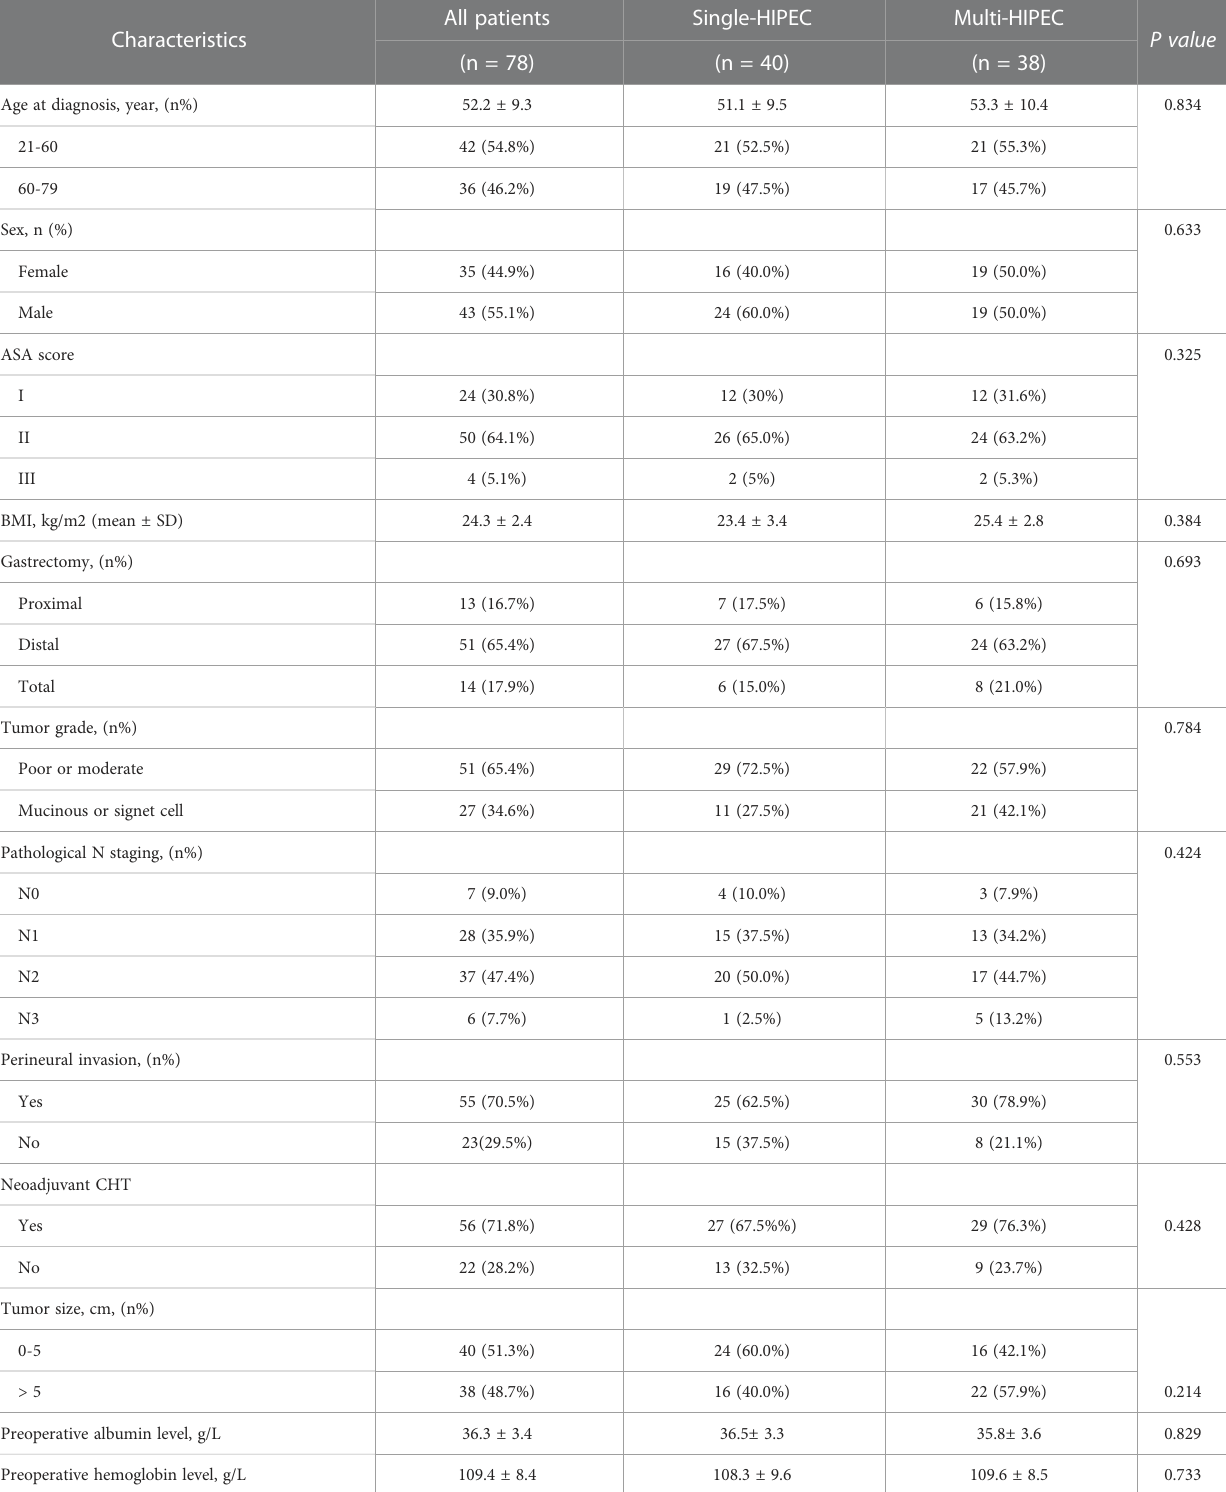
TABLE 1 Baseline characteristics of the patients with T4 gastric cancer.